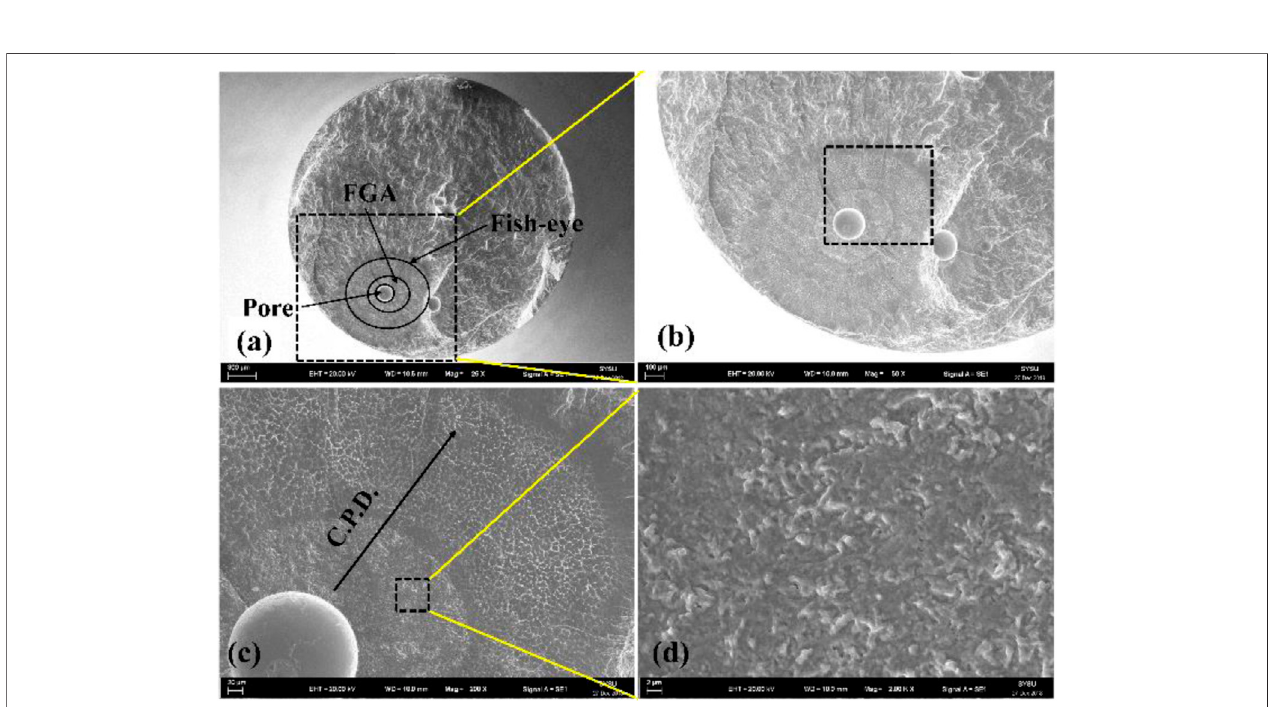
FIGURE 7 | Fracture surface of the specimen (LBW) tested at 260 MPa failed at 5.08 × 10 7 cycles. (A) overview of the fracture surface, (B) enlargement of the marked rectangle in (A,C) enlargement of the marked rectangle in (B,D) enlargement of the marked rectangle in (C) .